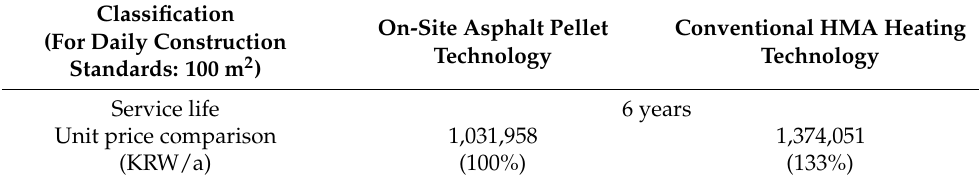
Table 10. Comparison of construction unit cost by packaging material.